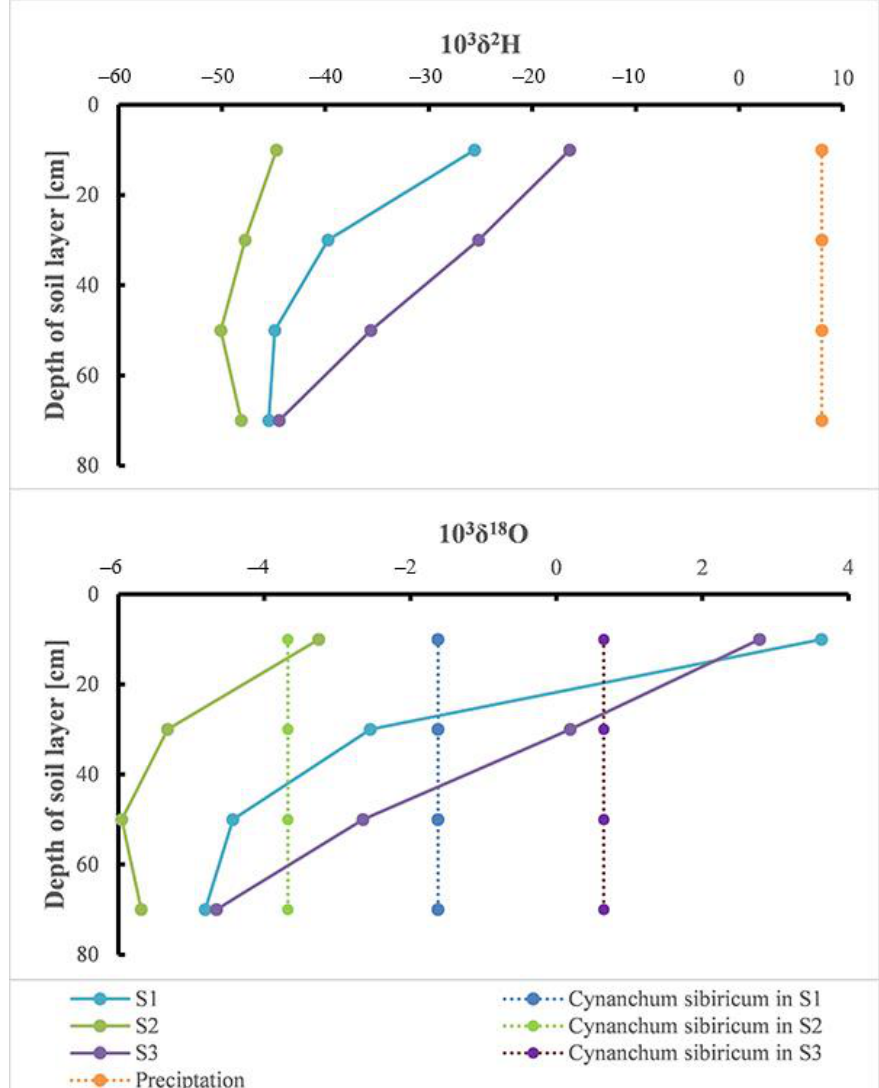
Figure 3. Soil water 2 H values (turquoise line for S1, green for S2, and purple for S3), as well as those of the meteorological water (orange dotted line), and δ 18 O values (same line type as 2 H) as well as those of according xylem water (respective dotted lines) of the species of the three depth profiles.